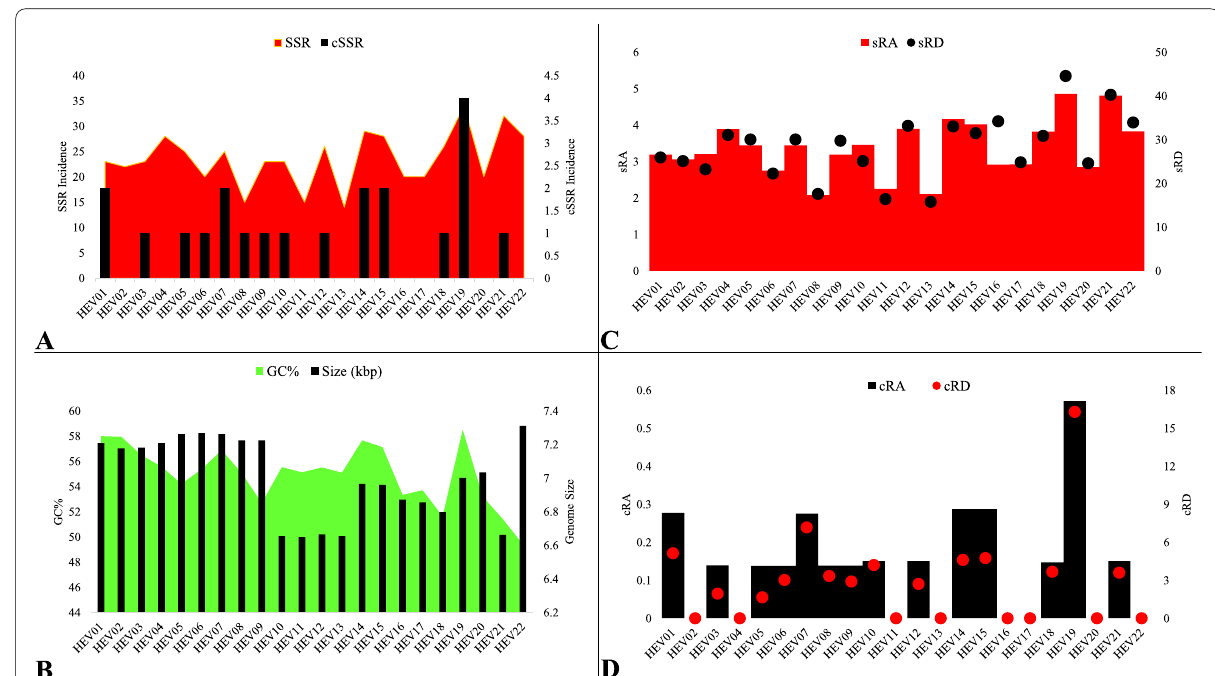
Fig. 1 Genome features and microsatellite incidence. A Incidence of SSR and cSSR. B Size of genome and GC content. C RA and RD of SSR. D RA and RD